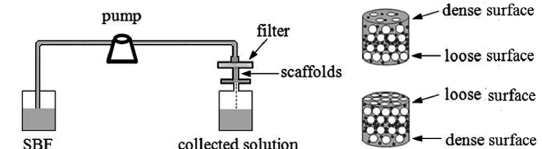
Figure 2. Continuous flow